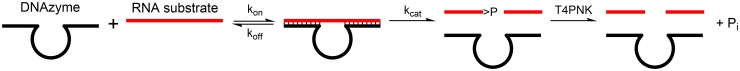
Kinetic model of DNAzyme reaction resulting in a product with a 2’,3’-cyclic phosphate (>P).